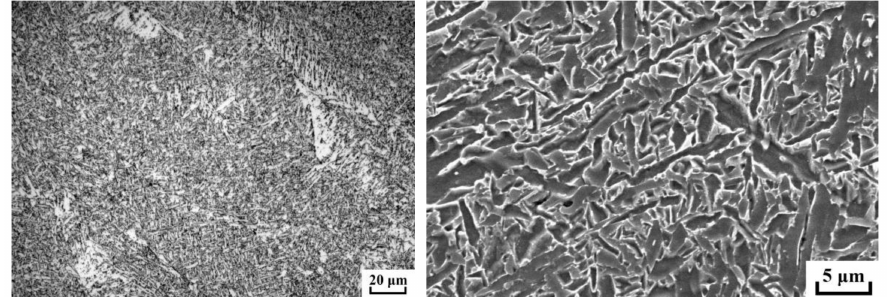
Figure 8. Microstructure of weld metal under